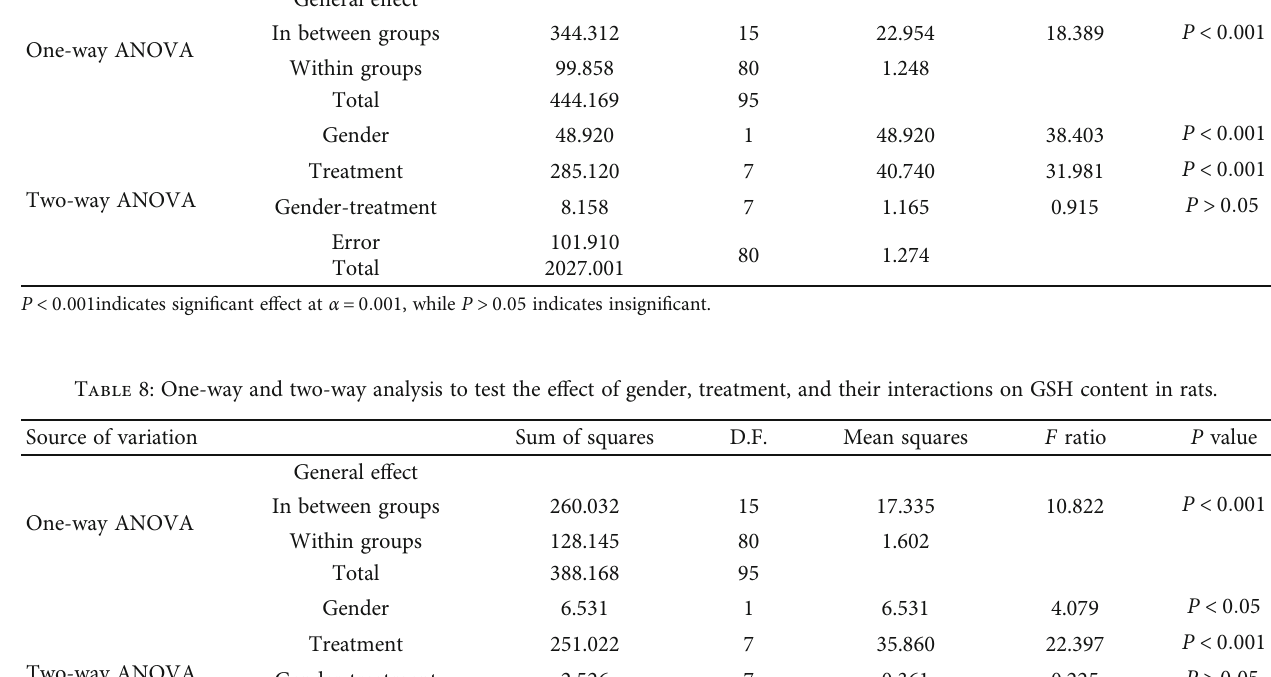
Table 7: One-way and two-way analysis to test the e ff ect of gender, treatment, and their interactions on MDA content in rats. Source of variation Sum of squares D.F. One-way ANOVA